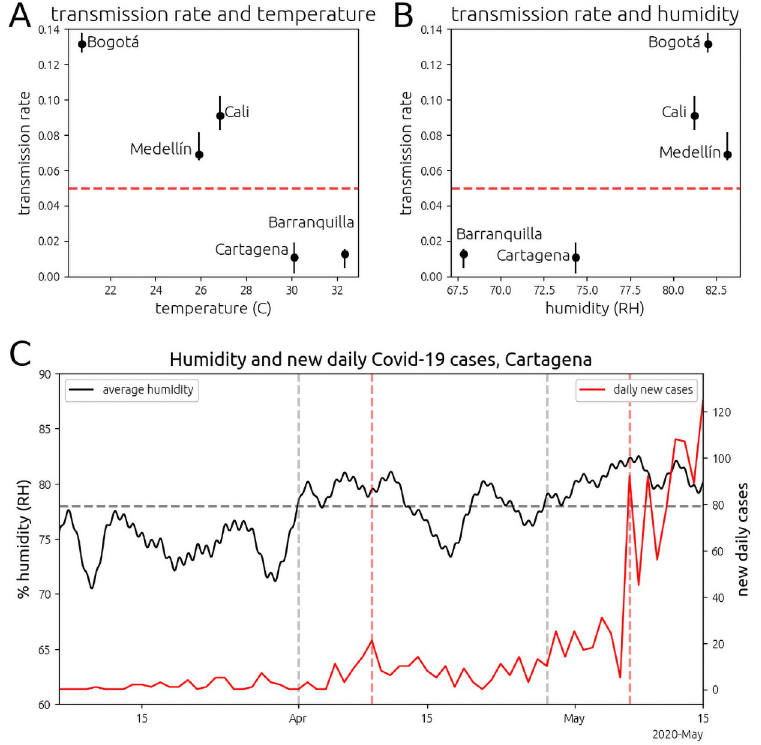
Fig 2. The transmission rate of SARS-CoV-2 with temperature and RH in the five largest cities of Colombia. (A,B) The dashed red line denotes a transmission rate of r = 0.05, which is our model’s threshold for observing clear exponential behavior and which we associate with airborne transmission. Note that these rates only apply to the pre- quarantine period. (C) Outbreak in Cartagena de Indias. The solid black line plots the average daily humidity in Cartagena (left axis). The solid red line plots the number of new cases of COVID-19 diagnosed in Cartagena (right axis). The horizontal dashed gray line plots a mean humidity level of 78%. The vertical dashed gray bar on the left denotes the first day with mean humidity at 78% since the first case of COVID-19 in Colombia. The first vertical dashed red line from the left, 8 days after the humidity increase, a spike in COVID-19 cases was registered. The second vertical dashed gray bar denotes the beginning of the second sustained period of humidity above 78% in Cartagena. A major outbreak began 9 days after the humidity